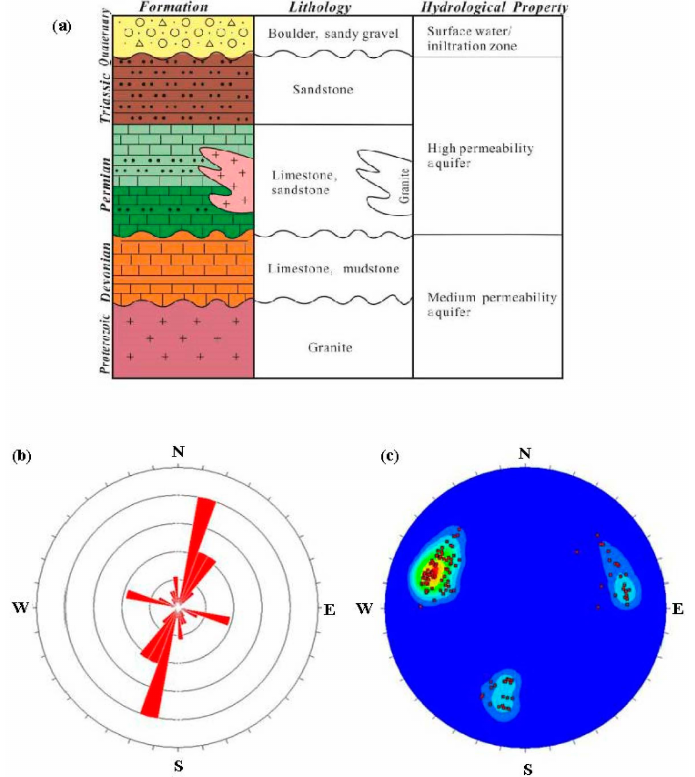
Figure 2. ( a ) Stratigraphic column showing lithology and hydrological properties; ( b ) Rose diagram and ( c ) stereographic diagrams (equal area projection, lower hemisphere) with poles and contouring of fractures in study area. Strata legends are same as Figure 1.